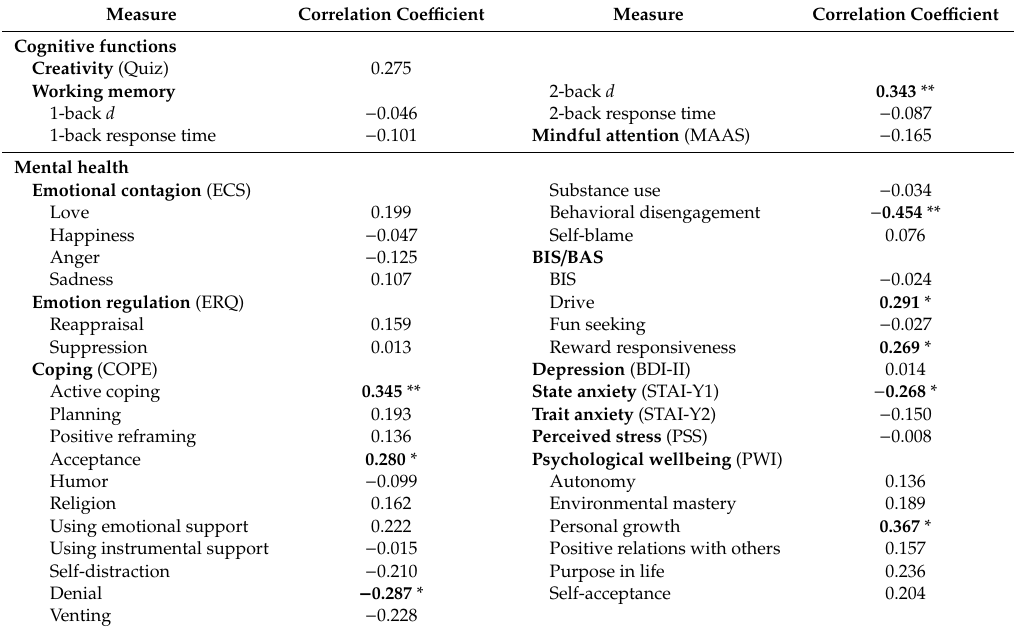
Table 3. Pearson correlations between the frequency of MVPA (moderate- to vigorous-intensity physical activity) and outcome variables. n = 49 for creativity and n = 58 for all other measures.